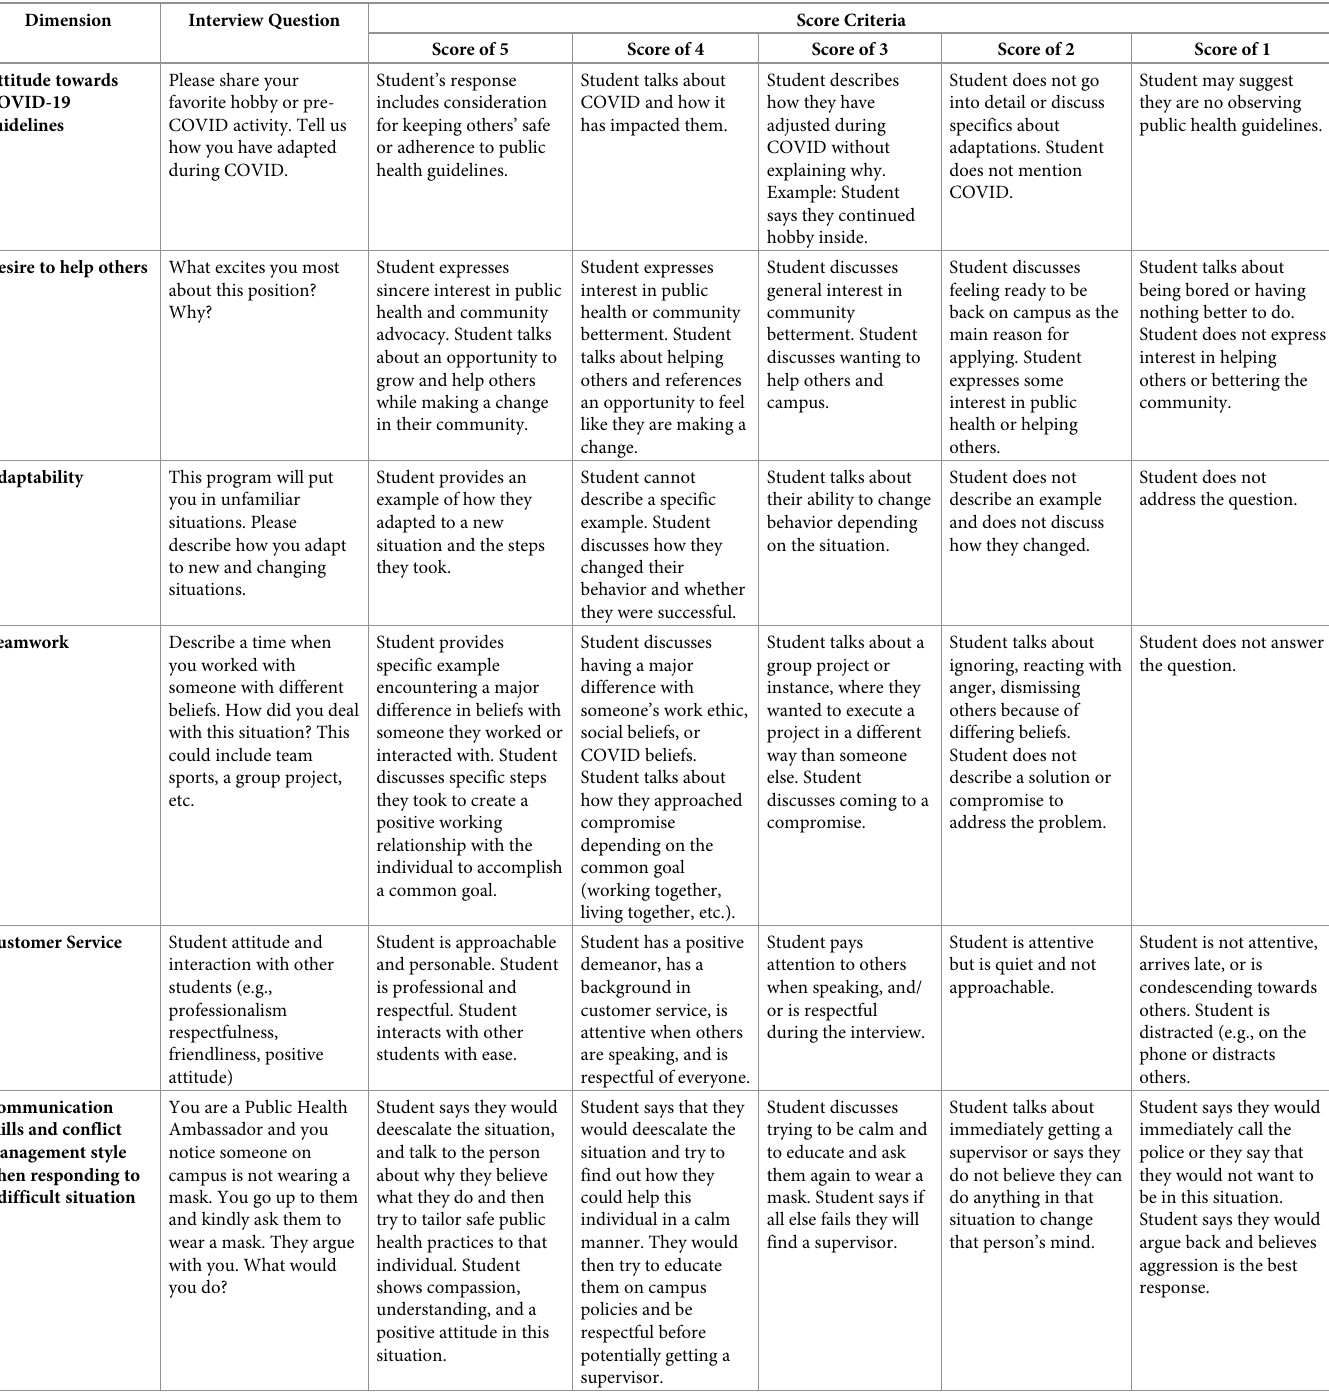
Table 1. Interview scoring criteria.